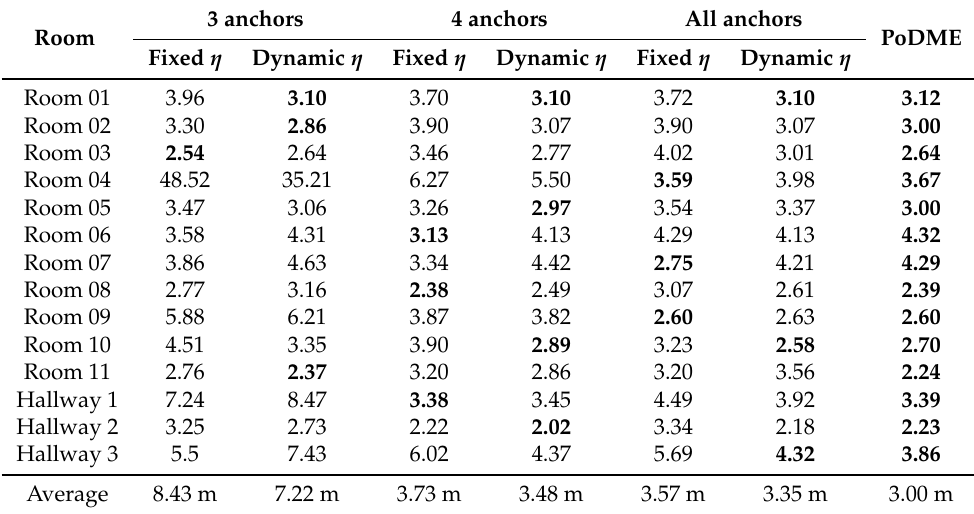
Table 3. Table with average error per room comparing the different approaches, highlighting the smallest mistakes compared to our approach.